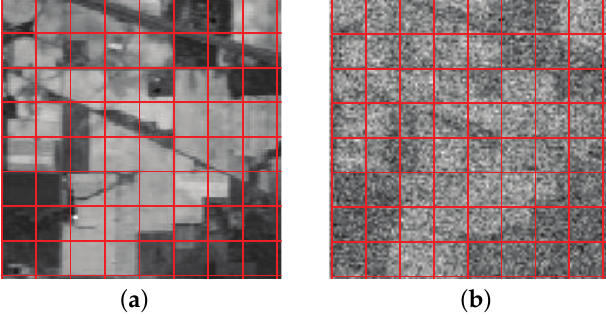
Figure 5. Part band images of Indian pines after grid division: ( a ) Grid image of the 120-th band; ( b ) grid image of the 200-th